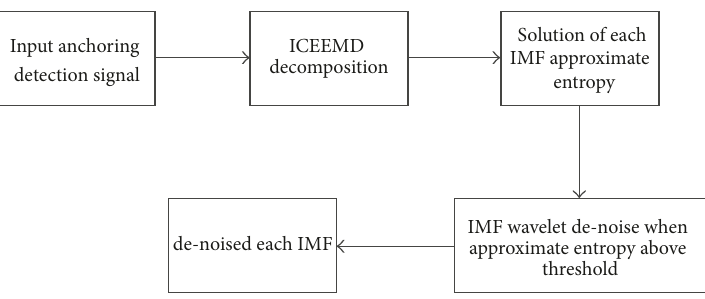
Figure 1: Anchoring detection signal analysis flowchart using